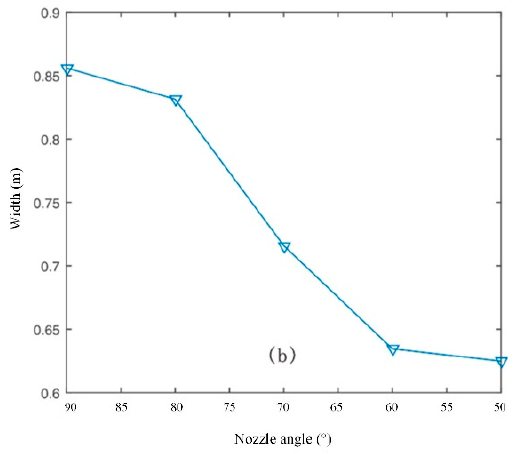
Figure 13. The correlation curve of scour depth and jet angle.